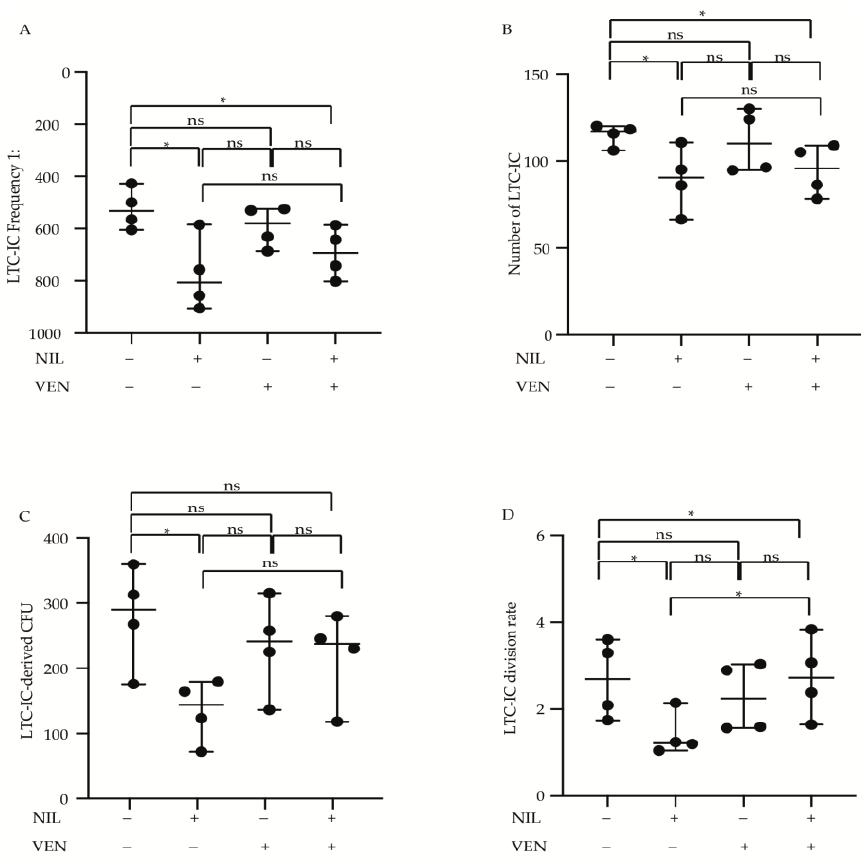
Figure 4. BCL2 and BCR-ABL1 kinase inhibition does not eliminate the primitive CML population. The scatter plot shows the LTC-IC frequency ( A ), number of LTC-IC ( B ), LTC-IC-derived CFU ( C ) and LTC-IC division rate ( D ) of the bone marrow primitive CD34-positive cells derived from CML patients ( n = 4) at diagnosis (Venetoclax 400 nM and Nilotinib 2 µ M). Data are reported as median with range obtained from each experiment performed in duplicate. Statistical significance was calculated by unpaired one-tailed t-tests with 95% confidence intervals ( p < 0.05 *, p < 0.01 **, p < 0.001 ***). UT = Untreated, VEN = Venetoclax, NIL = Nilotinib.